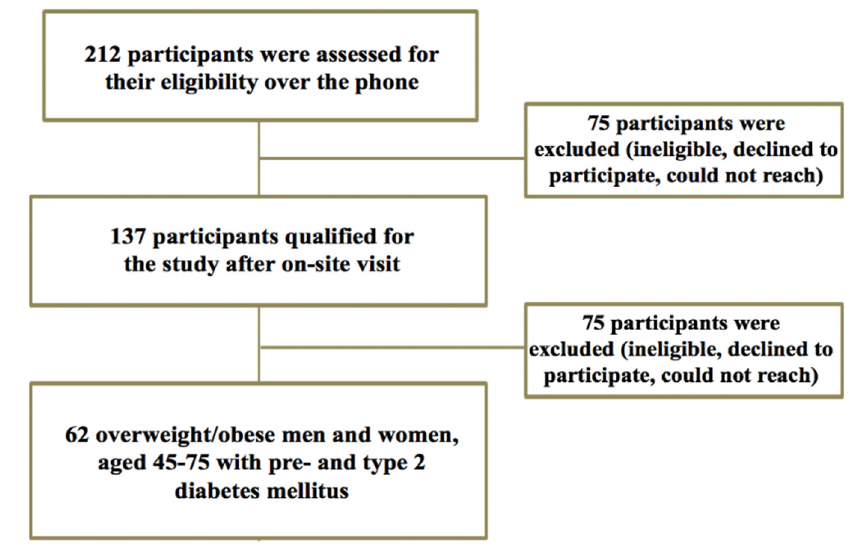
Figure 1. Study flowchart of recruitment and enrolment flowchart. Participants were excluded if they did not meet the inclusion criteria from questions over the phone or from on-site physical assessments and medical history questionnaires, declining participation, or not responding when contacted.